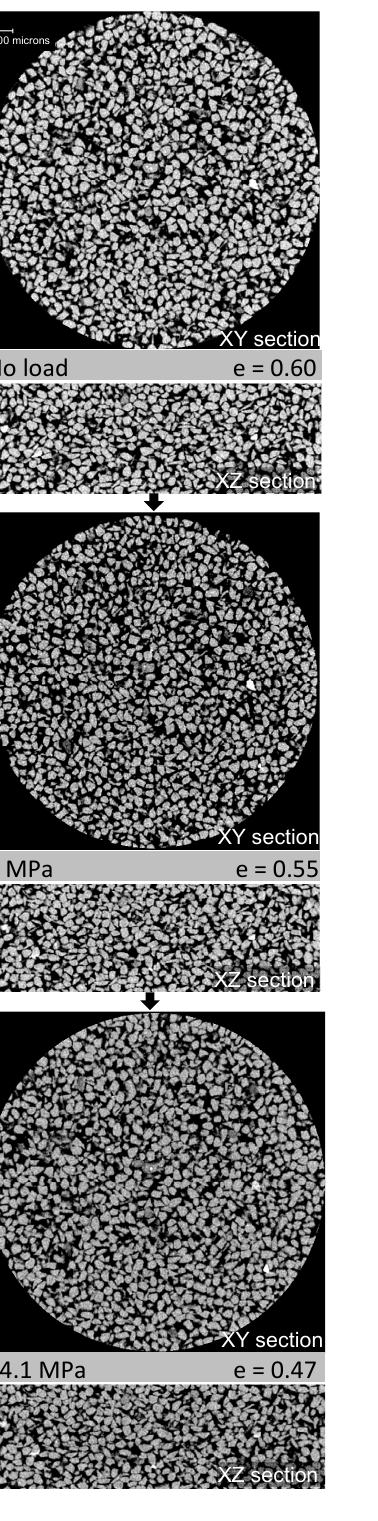
Figure 5. Horizontal and vertical image sections through the centre of the sample at different vertical stresses.